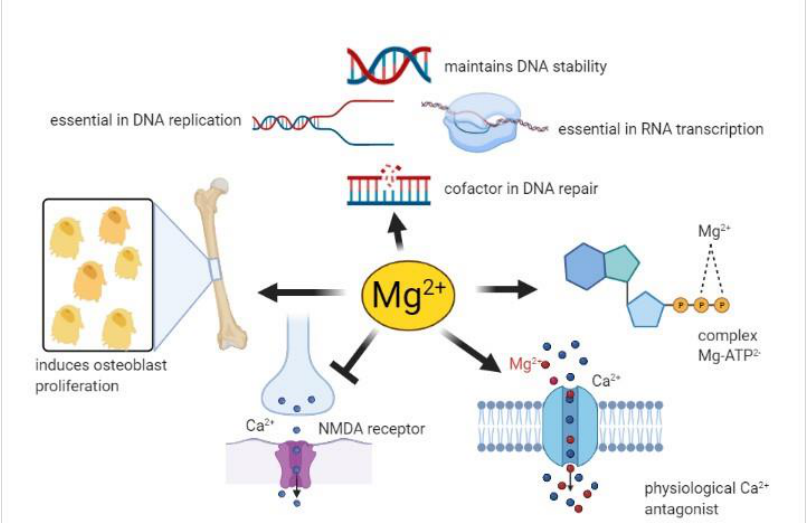
Figure 1. The biochemical involvement of magnesium in many cellular processes. This image is created with BioRender.com.